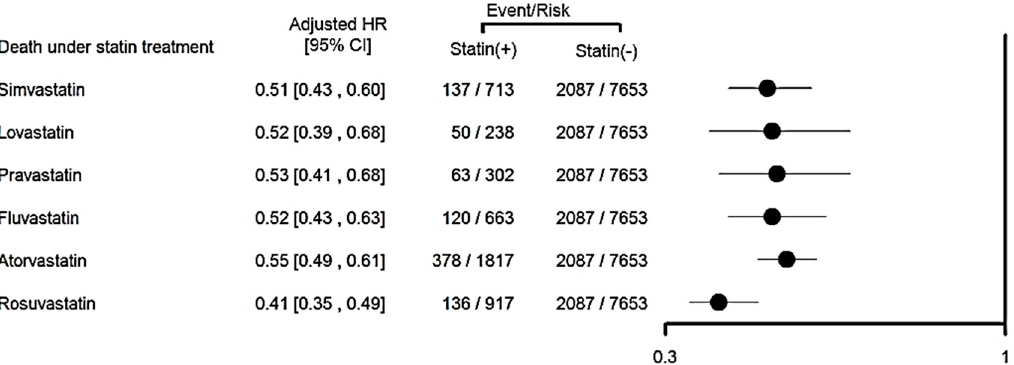
Figure 4. The dose ‐ response relationship between statins and the logit probability of all ‐ cause mortality using generalized additive modeling (GAM). The adjustments for factors are listed in Table 1. The dotted line indicates 95% confidence intervals. 4. Discussion Our study supports the clinical benefit of statin therapy among advanced CKD patients in the reduction of all ‐ cause mortality and especially sepsis ‐ related mortality. In addition, after the competing risk for mortality taken into account, statin therapy was not associated with an increased risk of NODM, nor was it associated with a decreased incidence of de novo MACE.